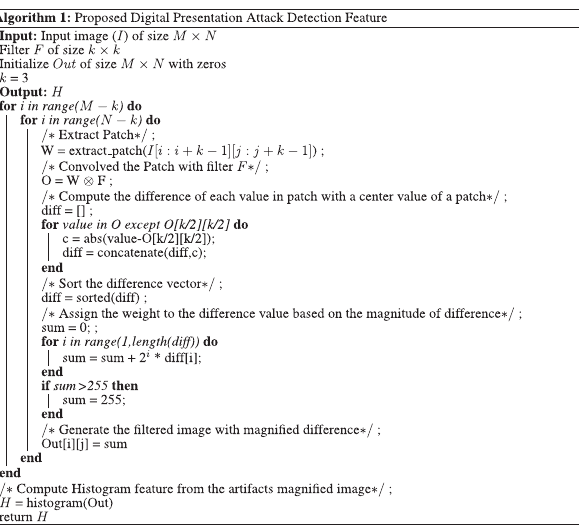
proposed digital presentation attack detection algorithm can surpass existing algorithms by a signi fi cant margin.